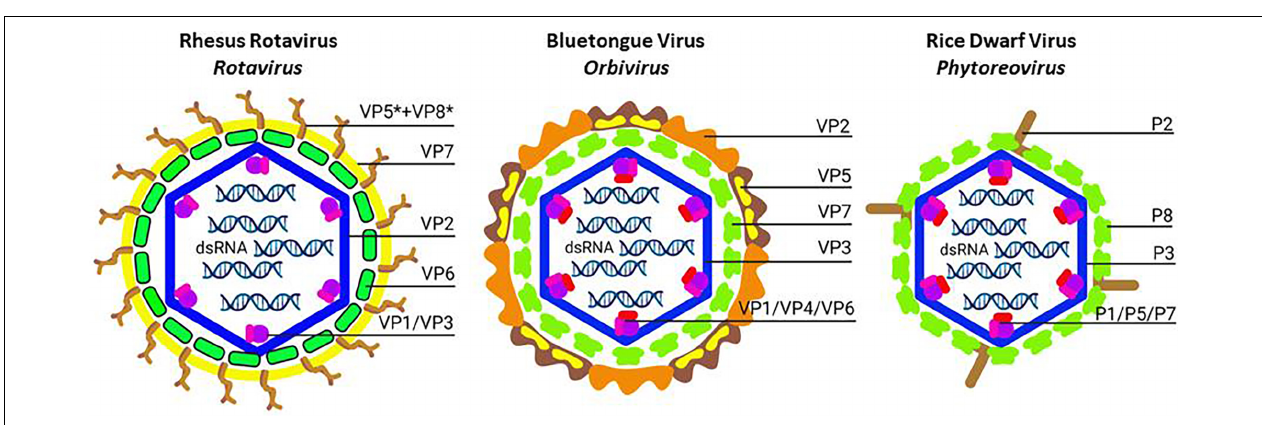
proteins λ 1 (inner shell), λ 2 (turret) and σ 2 (clamp) ( Figure 1 and Table 2 ; Gummersheimer and Danthi,